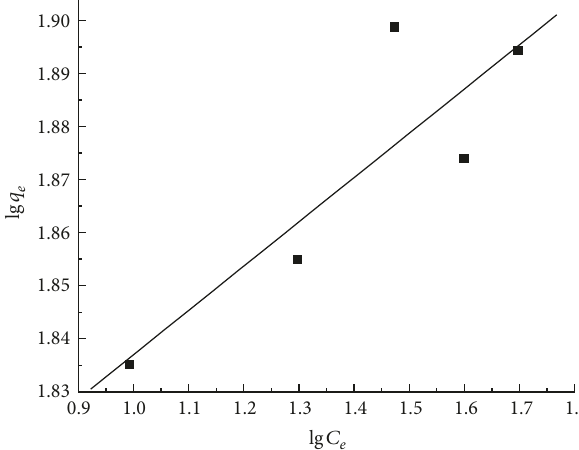
Figure 7: Effect of initial concentration for Cr(VI) adsorption using hybrid membrane of carboxymethyl chitosan and silicon dioxide.